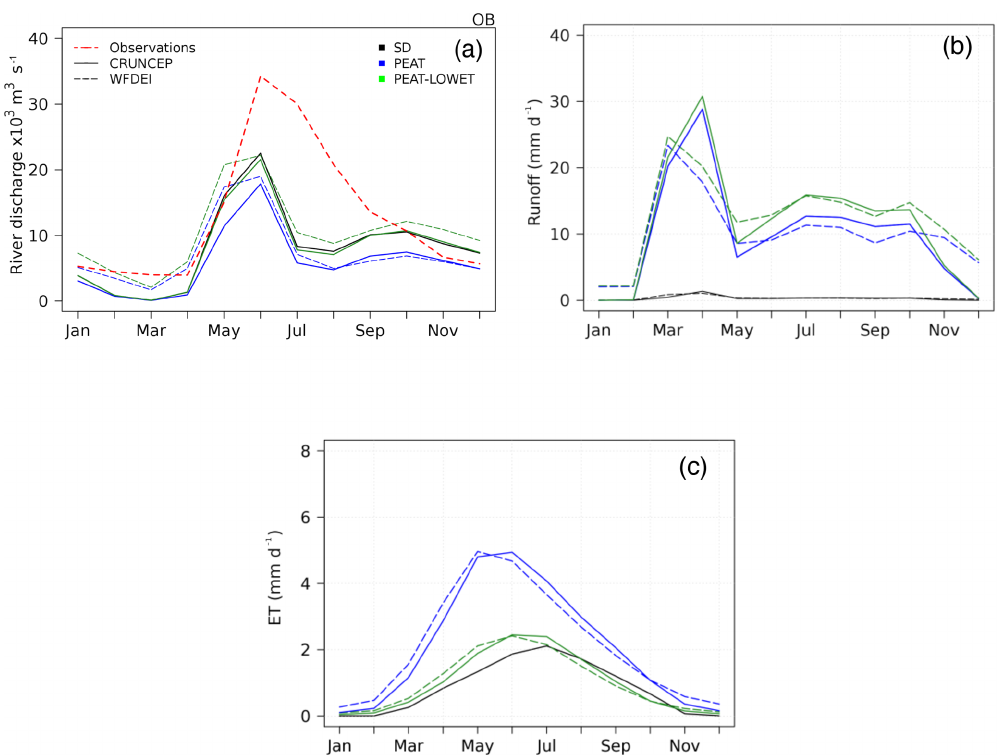
Figure 9. (a) Mean annual cycle of river discharge, (b) runoff of peat soils and (c) evapotranspiration of peatlands, for the Ob river basin. The observed river discharge is represented in red. The simulation are given with the standard version of ORCHIDEE-HL (STD, black), with peatlands scheme without (PEAT, blue) and with the reduced (PEAT-LOWET, green) evaporation, using the meteorological forcing CRUNCEP (full line) and WFDEI (dashed